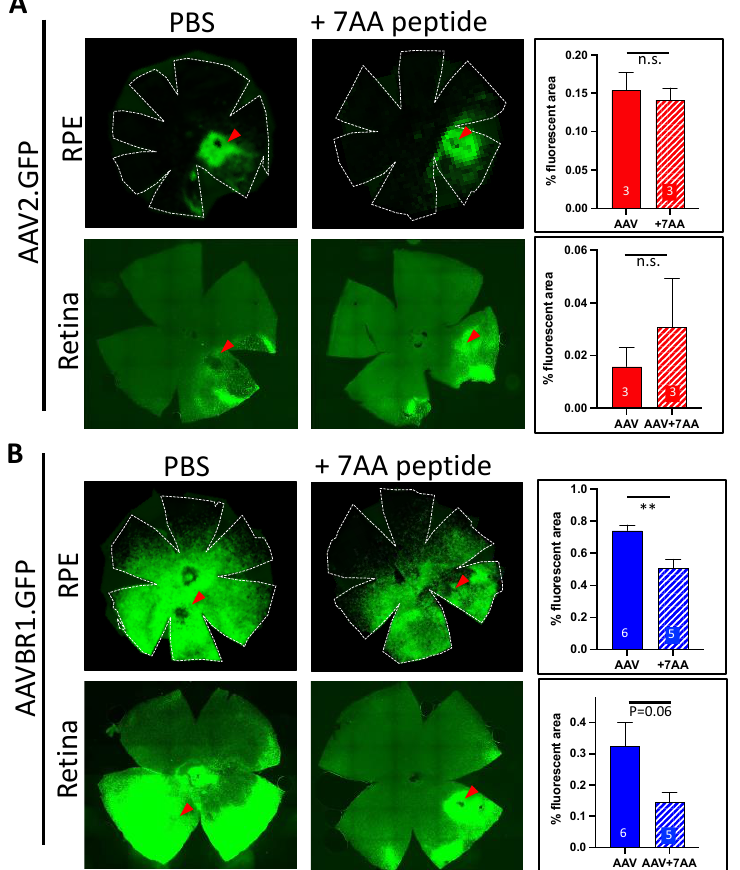
0.0 AAV AAV+7AA